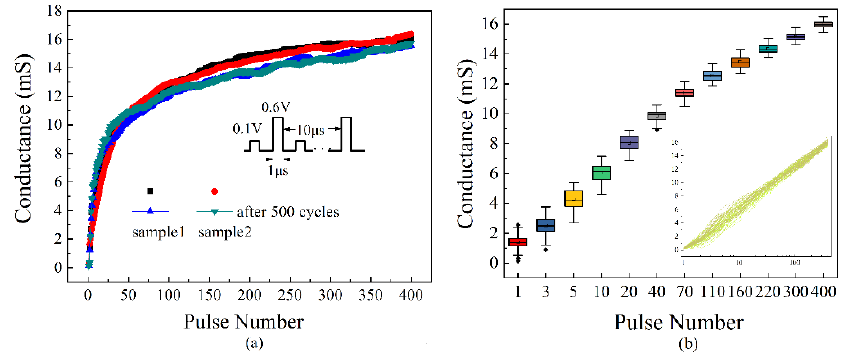
Figure 6. ( a ) Device conductance is shown as a function of the applied voltage pulse number for ON switching for 2 different devices. ( b ) The conductance of the device at different pulse periods for 100 different devices; the illustration shows actual data. The conductance was calculated by the Source Measurement Unit (SMU) (V read = 0.1 V), and the set pulse by 0.6 V amplitude, 1 μs pulse width, and square-waveform voltage pulse (rise time = 50 ns). The 500-cycle endurance test outcome is notable. One cycle includes 400 set consecutive pulses.